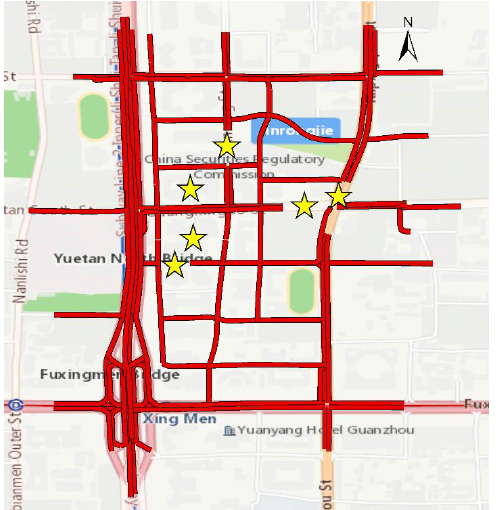
Figure 4. Layout of the sub-transportation network in Beijing.